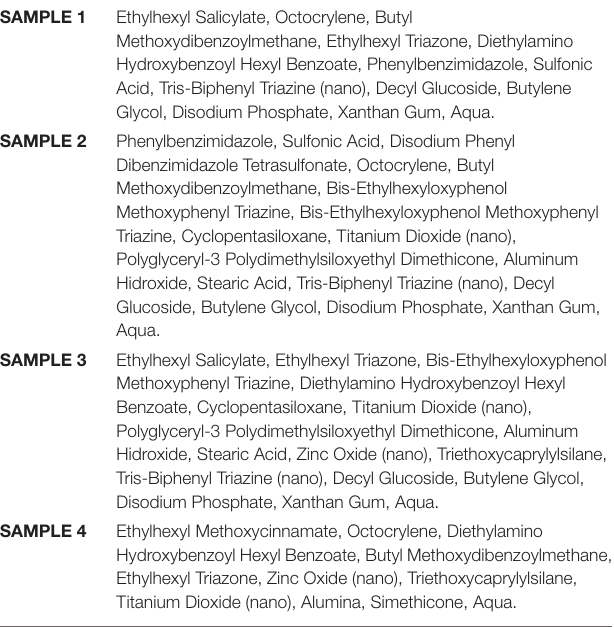
TABLE 1 | Different combinations of UVB and UVA organic and mineral filters used to prepare the experimental sunscreens used throughout the study. SAMPLE